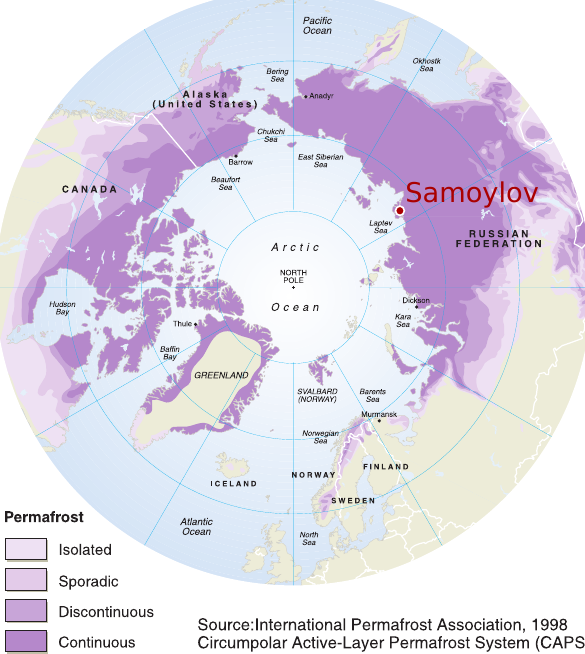
Figure 2. Map showing location of Samoylov Island and Northern Hemisphere permafrost distribution (Brown et al.,